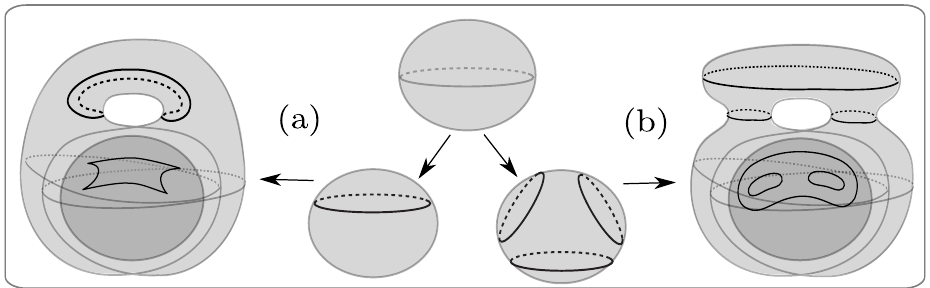
Figure 1. Example of stable maps from S 2 to S 2 with dregree 2: ( a ) unique singular curve with four cusp points; ( b ) fold map with three singular